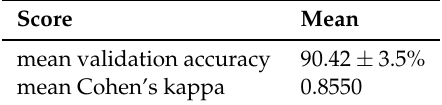
Table 6. Efficacy of the environmental impact classification model for 10-fold cross validation.